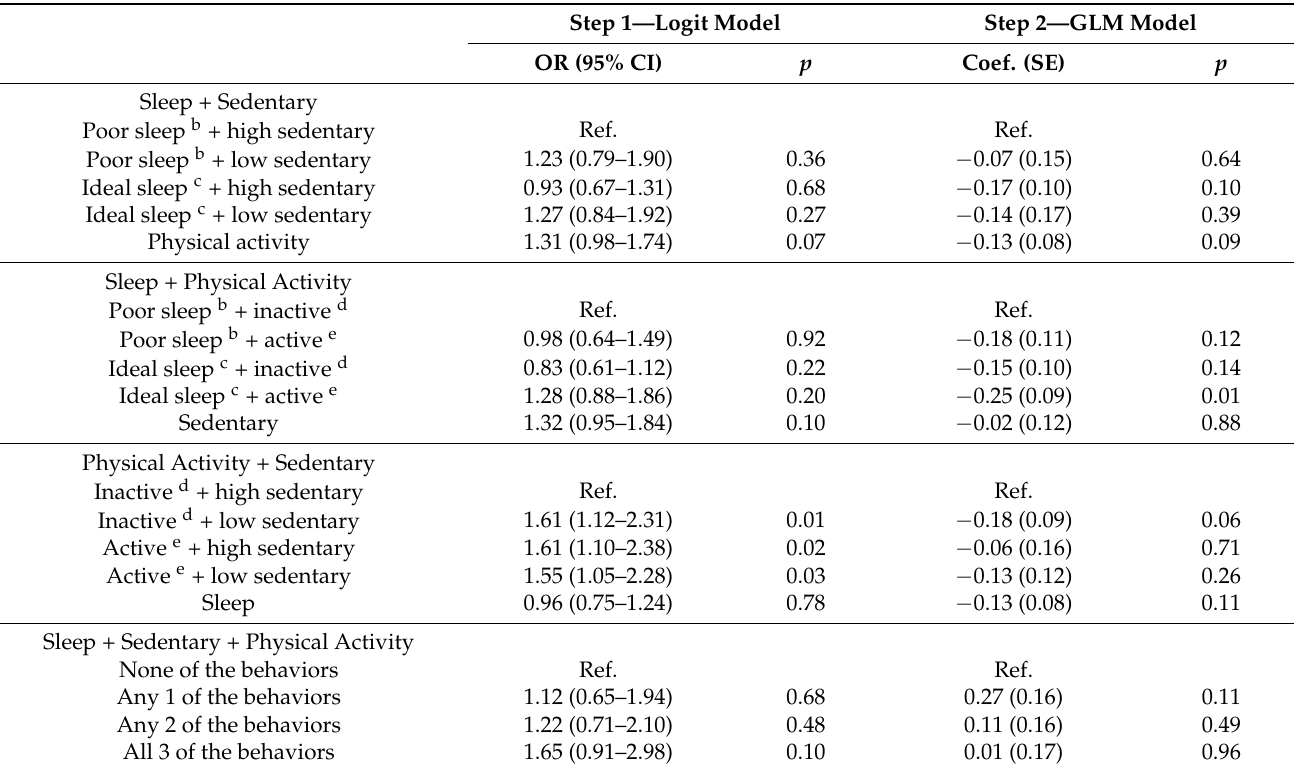
Table 4. Two-step regression analysis of joint associations of sleep, sedentary time, and physical activity with long-term weight loss success a . Step 1—Logit Model Step 2—GLM Model OR (95% CI) p Coef.